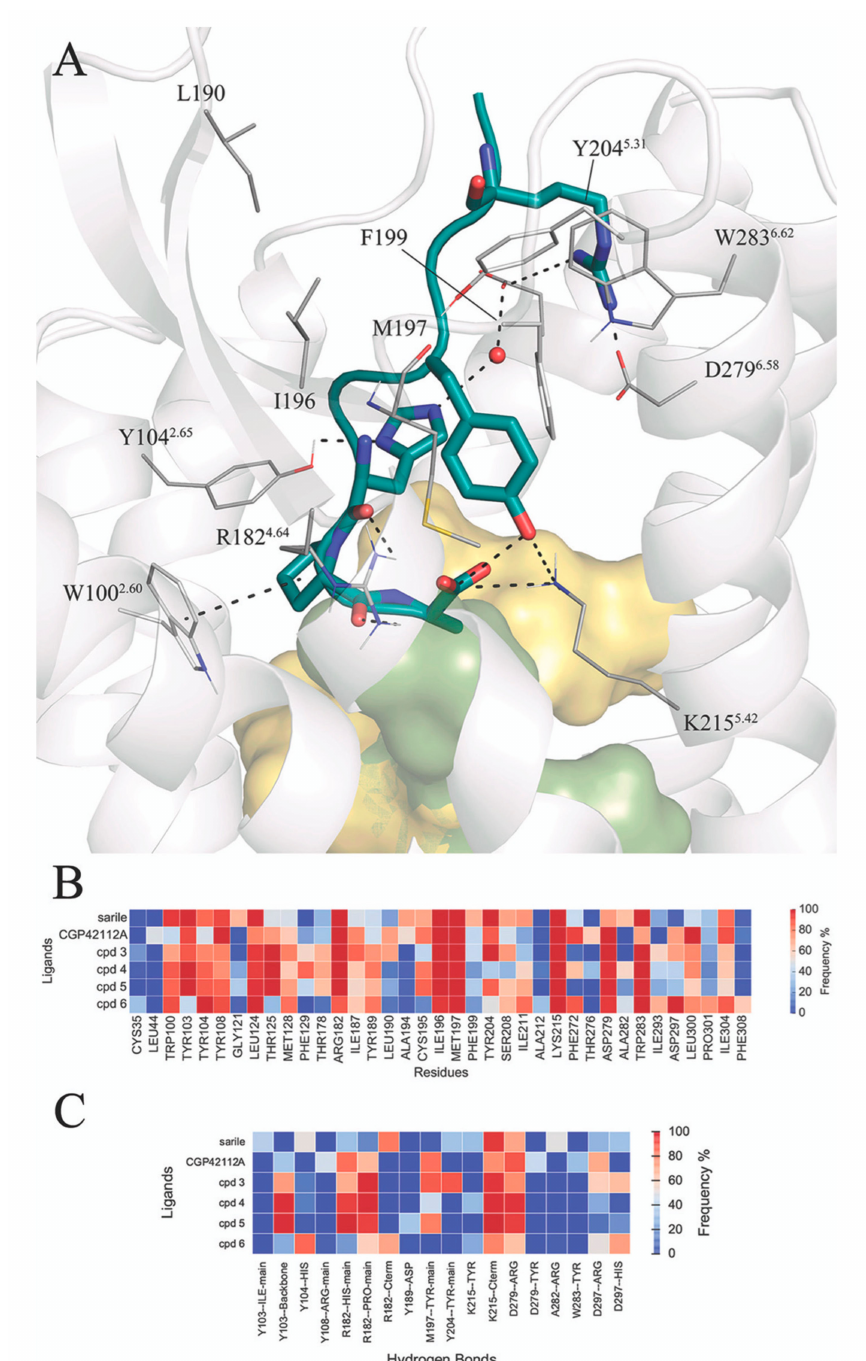
Figure 3. ( A ) Schematic representation of the octapeptide analogues 1 – 6 in the AT2R binding site. The hydrophobic pocket surrounding the C-terminus is depicted as a surface (yellow for Ile 8 , green for Phe 8 ), the receptor residues in contact with the common sidechains of the peptides (see panel B) are explicitly represented and hydrogen bonds with high frequency (see panel C). The heat-maps represent atom contacts ( B ) and hydrogen bonds ( C ) occurring more than 30% of the simulation time between at least one peptide and the